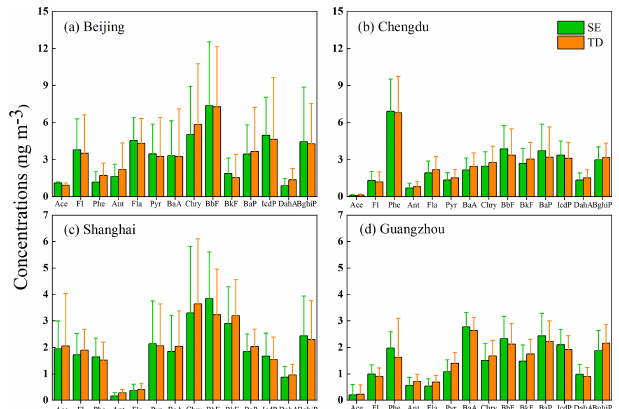
Figure 5. Average concentration of individual PAHs determined by SE-GC-MS and TD-GC-MS methods during wintertime from De- cember 2013 to January 2014 in Beijing (a) , Chengdu (b) , Shang- hai (c) and Guangzhou (d) . Error bar is one standard deviation of individual PAHs.